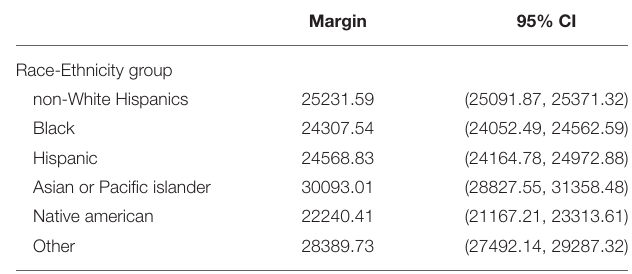
TABLE 4 | Multivariate analysis of in-hospital mortality, by race-ethnicity group.